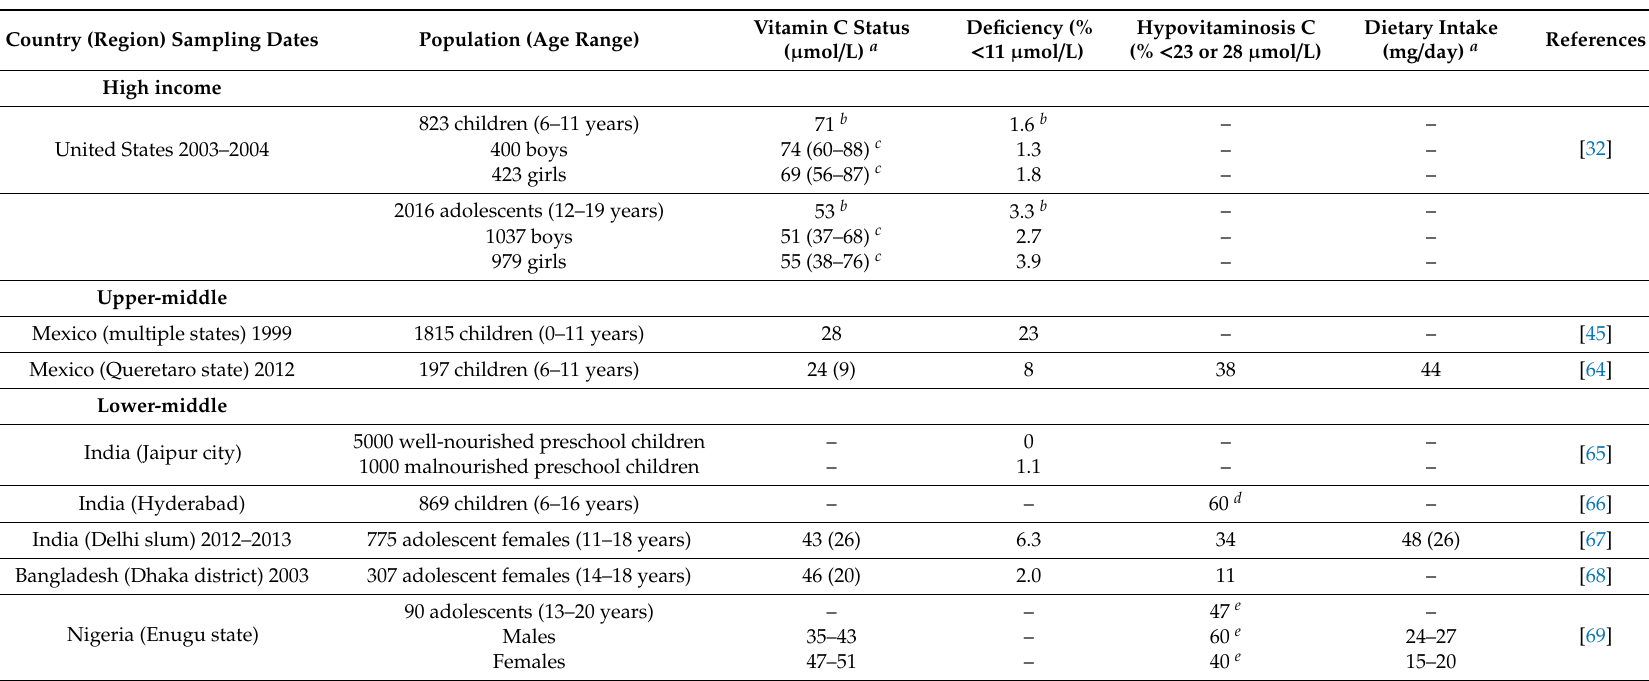
Table 3. Vitamin C status and prevalence of deficiency and hypovitaminosis C of children and adolescents